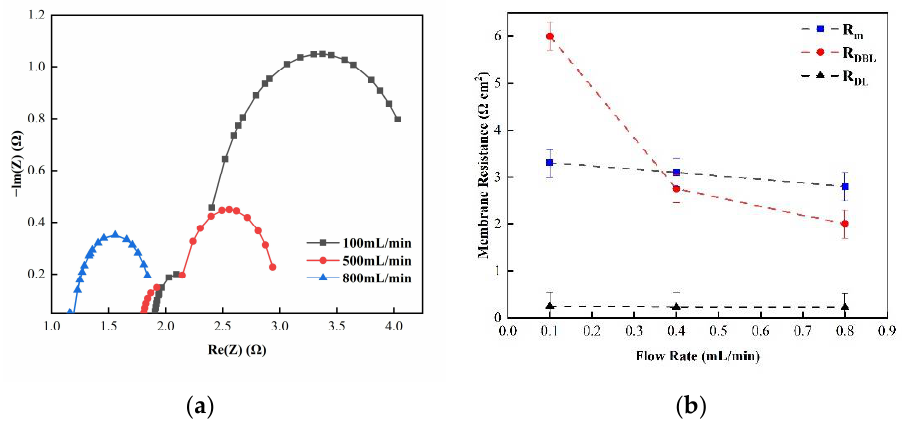
Figure 11. ( a ) The impedance of the Nyquist spectrum and ( b ) membrane the impedance(R M ), double layer impedance (R DL ), and diffusion layer impedance (R DBL ) of the FO membrane in 0.5 M NaCl